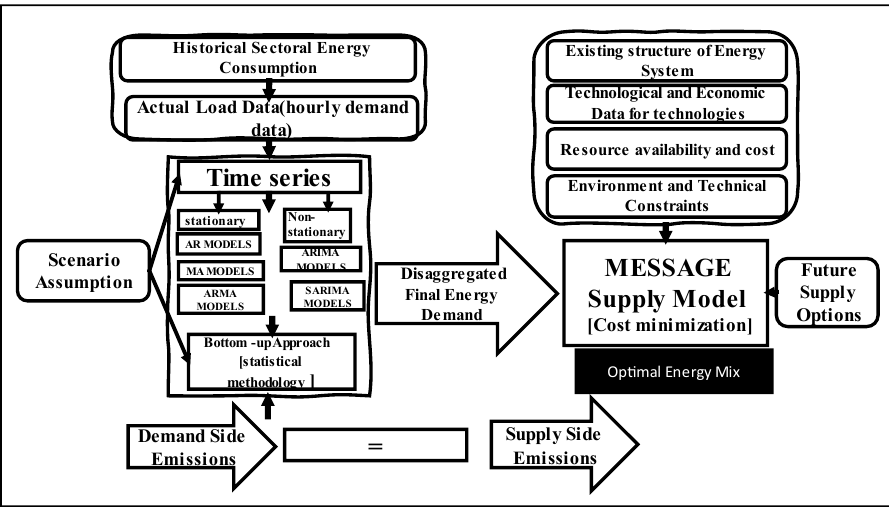
Figure 3. Overall concept of an integrated energy model in this study.